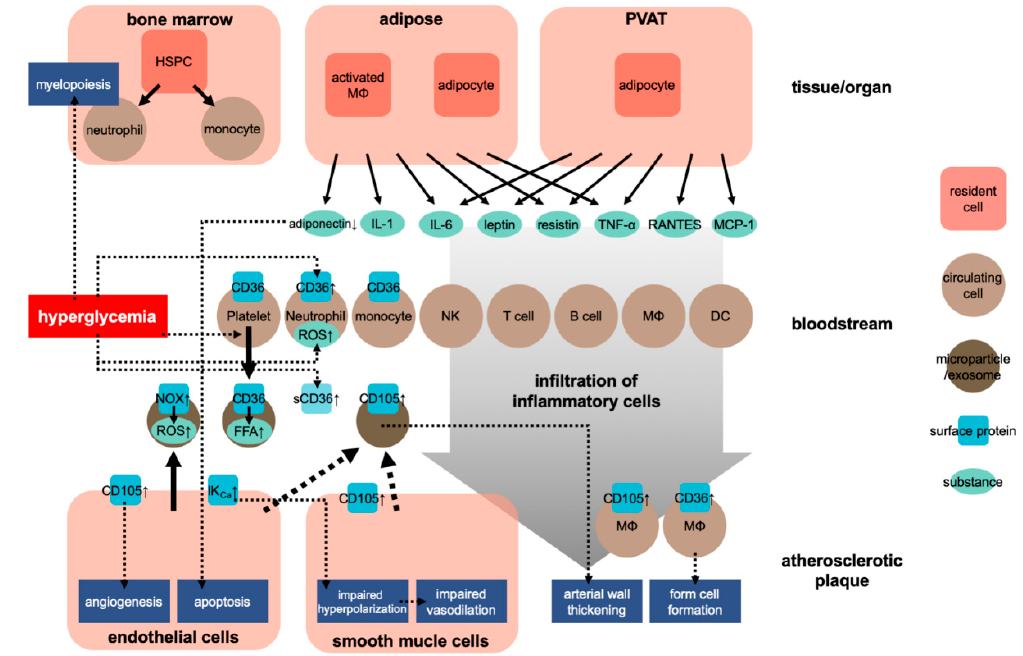
Figure 1. Development of atherosclerosis in obesity. HSPC, hematopoietic stem and progenitor cells; NK, natural killer cell; M Φ , macrophage; DC, dendritic cell; sCD36, soluble CD36; ↑ , upregulation.